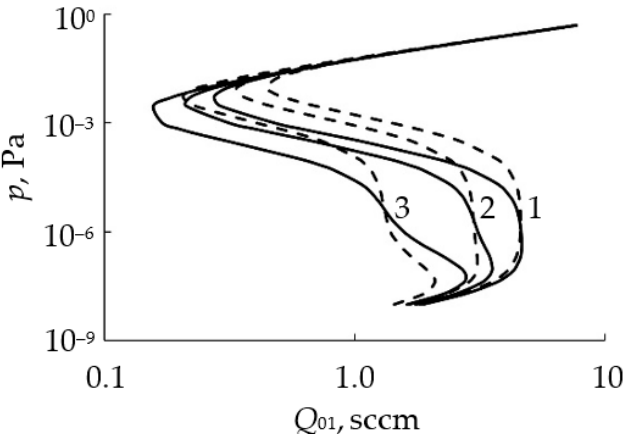
Figure 24. Dependence of oxygen partial pressure on Q 01 for cold (solid lines) and hot (dashed lines) targets at the discharge current density of 200 A/m 2 and values Q 02 (sccm): 1—0.1; 2—0.2;